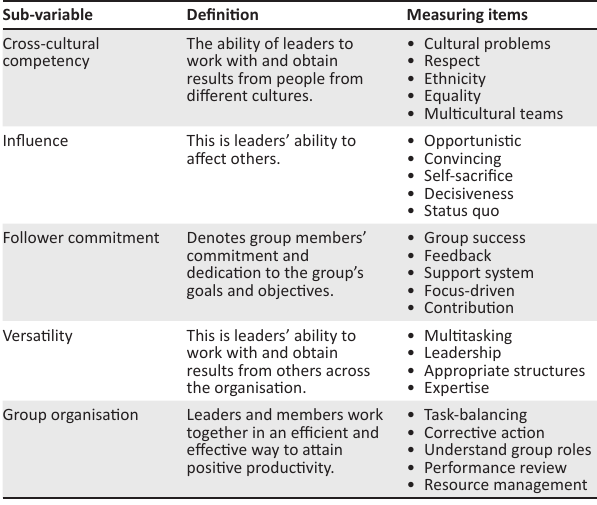
TABLE 2: The sub-variables of leadership effectiveness. TABLE 1: The sub-variables of strategic thinking